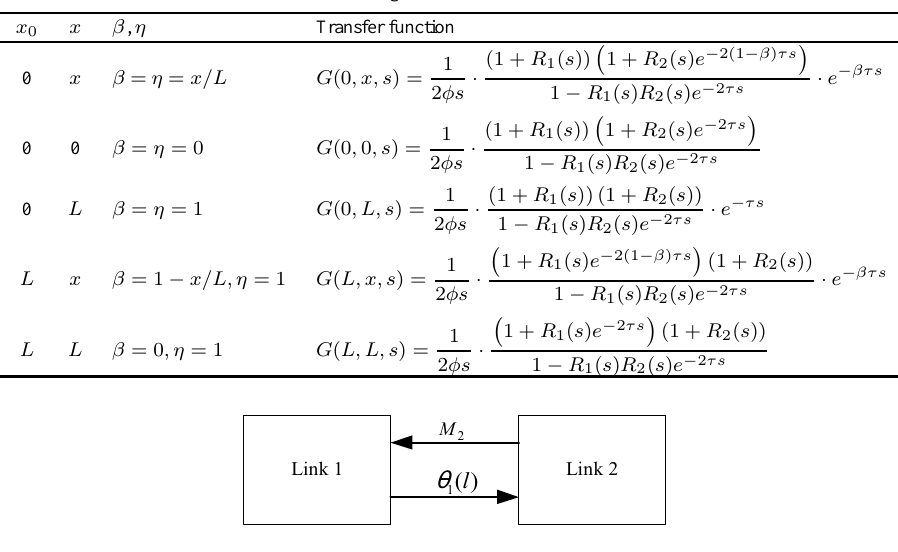
Fig. 3. Natural feedback between links 1 and